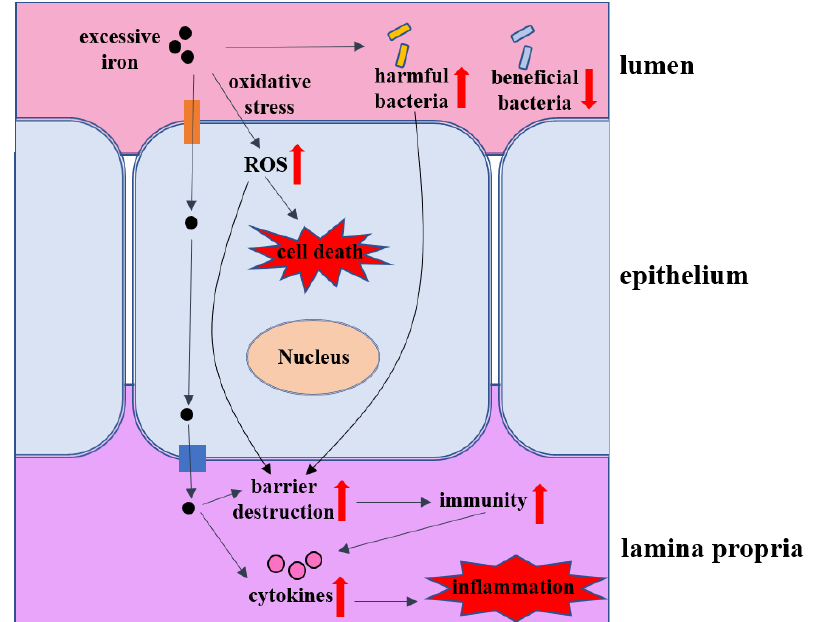
Figure 3. The impacts of iron overload on intestinal homeostasis. The impacts of iron overload on intestine mainly focus on the changes of the intestinal barrier, intestinal immunity, inflammation, intestinal microbes, transport channels and cell death. Excessive iron can damage the intestinal barrier by iron-induced ROS and exacerbate the inflammatory response. Iron overload can cause the disturbances in the intestinal microbiota, which reduces the number of probiotics, while increasing the number of pathogenic bacteria. In addition, iron-induced ROS can result in intestinal cell death, including ferroptosis.